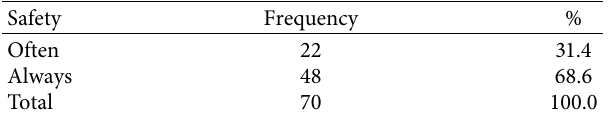
Table 13: Safety.